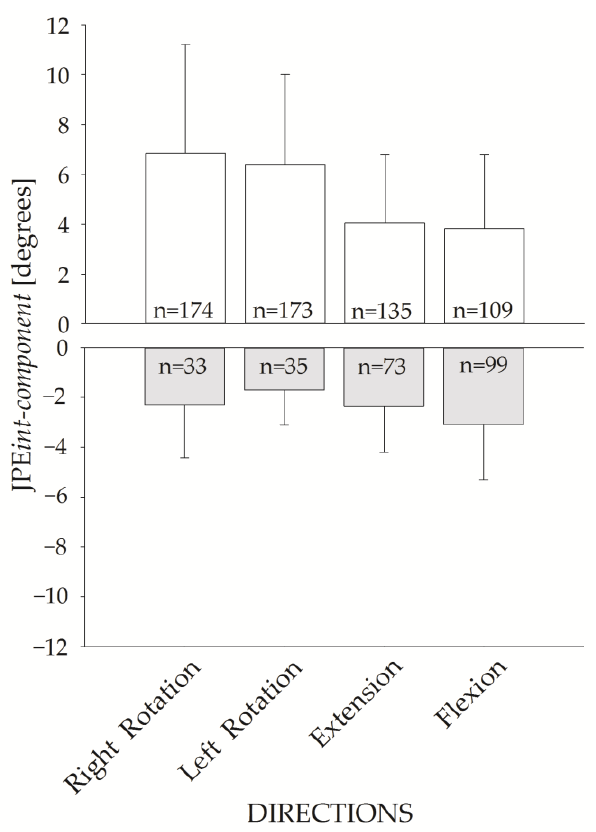
Figure 7. JPE int-component bar plot for the four movement directions. Hypermetric (white bars) and hypometric (grey bars) JPE int-component (mean and standard deviation) are represented. The corresponding number of hypermetric vs. hypometric trials is shown inside each bar.